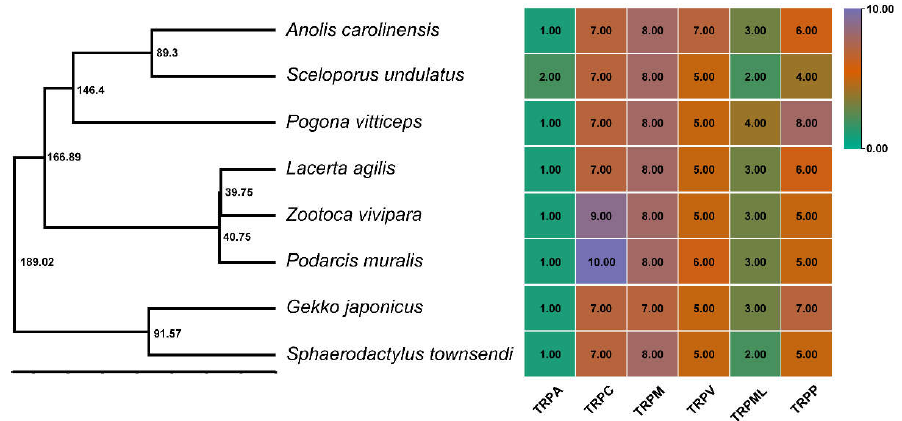
Figure 1. Species tree of eight saurian and TRP numbers of each species. The time tree of the eight saurian was built by the TIMETREE 5 ( left , the number is the divergence time), and the numbers of the TRP family detected in each species were listed accordingly ( right ). the TRP family detected in each species were listed accordingly ( right